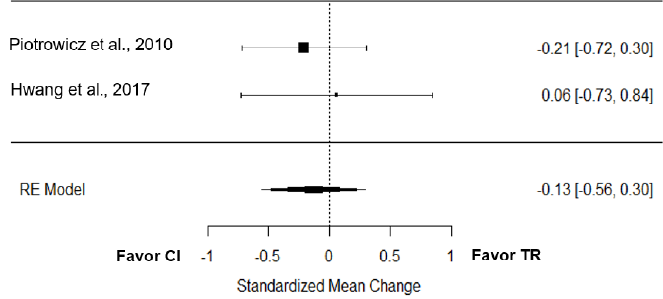
Figure 4. Effect of TR on the 6MWD compared to CI [19,25].